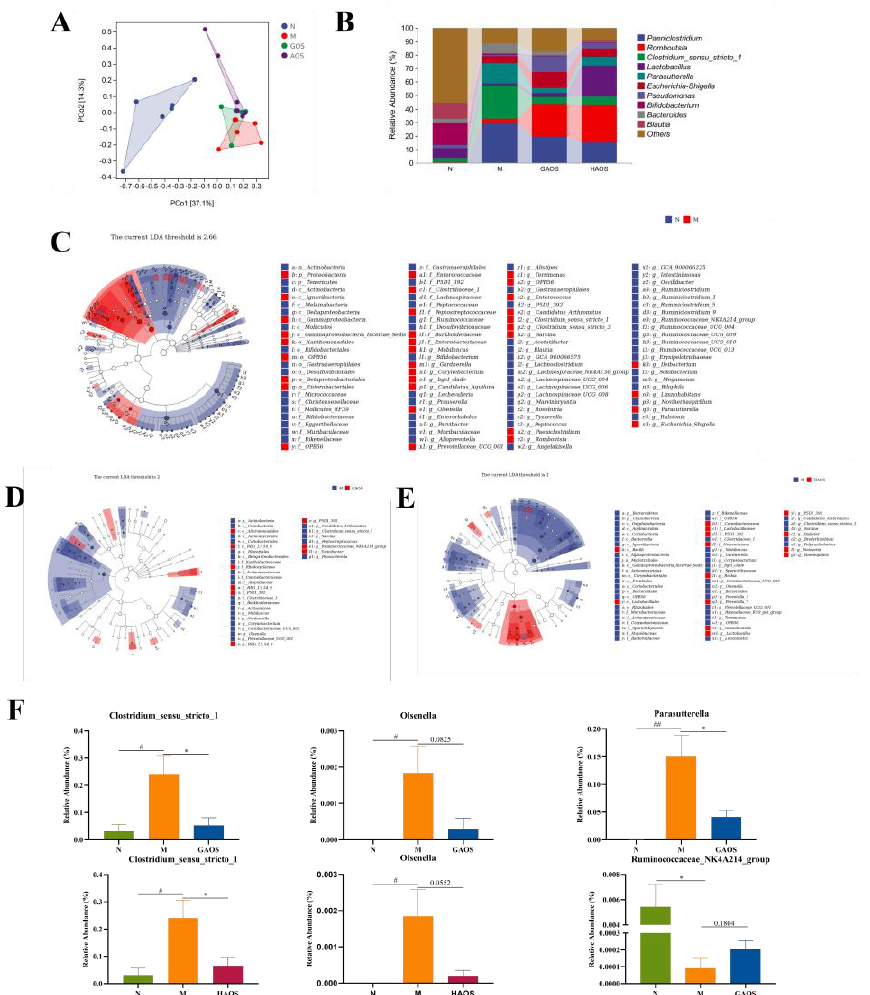
Figure 5. Effects of alginate oligosaccharides administration on gut microbiota in DSS-induced colitis mice. ( A ) Principal component analysis (PCA) with the cluster. ( B ) Microbial distributions of different groups at the genus level. LDA distribution. Linear discriminate analysis effect size (LEfSe) was performed to determine the difference in abundance; the threshold of the LDA score was 2.0. ( C ) The LEfSe analysis between N and M. ( D ) The LEfSe analysis between M and GAOS. ( E ) The LEfSe analysis between M and HAOS. ( F ) The relative abundance of Clostridiaceae_1 , Olsenella , Parasutterella, and Ruminoccaceae_NK4A214_group . Data were mean ± SEM ( n = 6). # p < 0.05, ## p < 0.01 vs. the N group; * p < 0.05 vs. the M group.